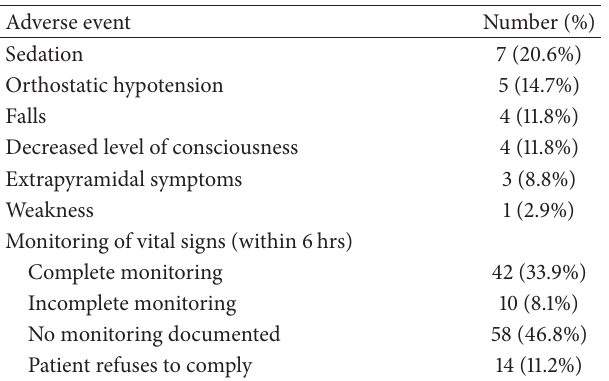
Table 3: Documented adverse events and monitoring among cases that received olanzapine